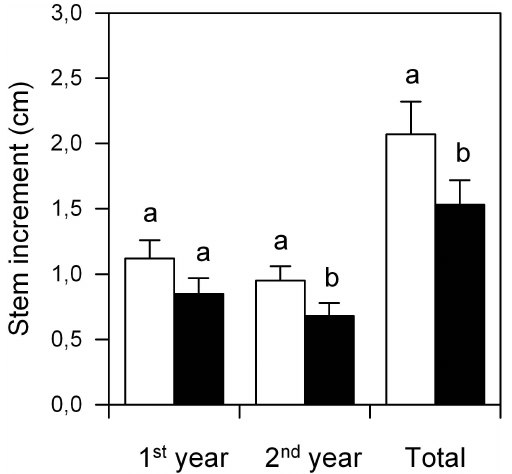
Fig. 3. Annual stem diameter increment (cm) for the first and sec- ond year, and for the whole desiccation period for C. acuminatis- sima trees from control ( (cid:3) , n = 5) and drought ( (cid:4) , n = 9) plots. Values are means ± 1SE. Small letters indicate significant differ- ences between the two treatments ( p ≤ 0 . 1). Fig. 4. Relation between isotope ratios of carbon and oxygen in